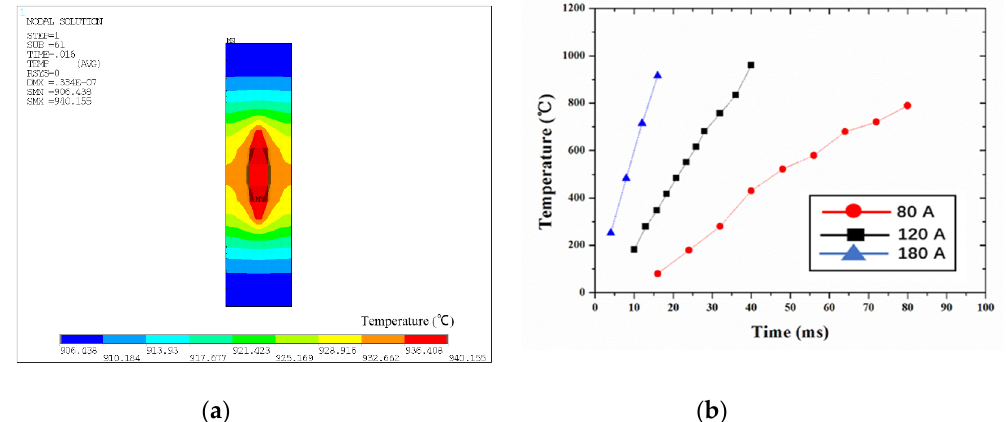
Figure 12. ( a ) The temperature field distribution of the Au thick film. ( b ) The time variation of the maximum temperature of the Au thick film using different currents.